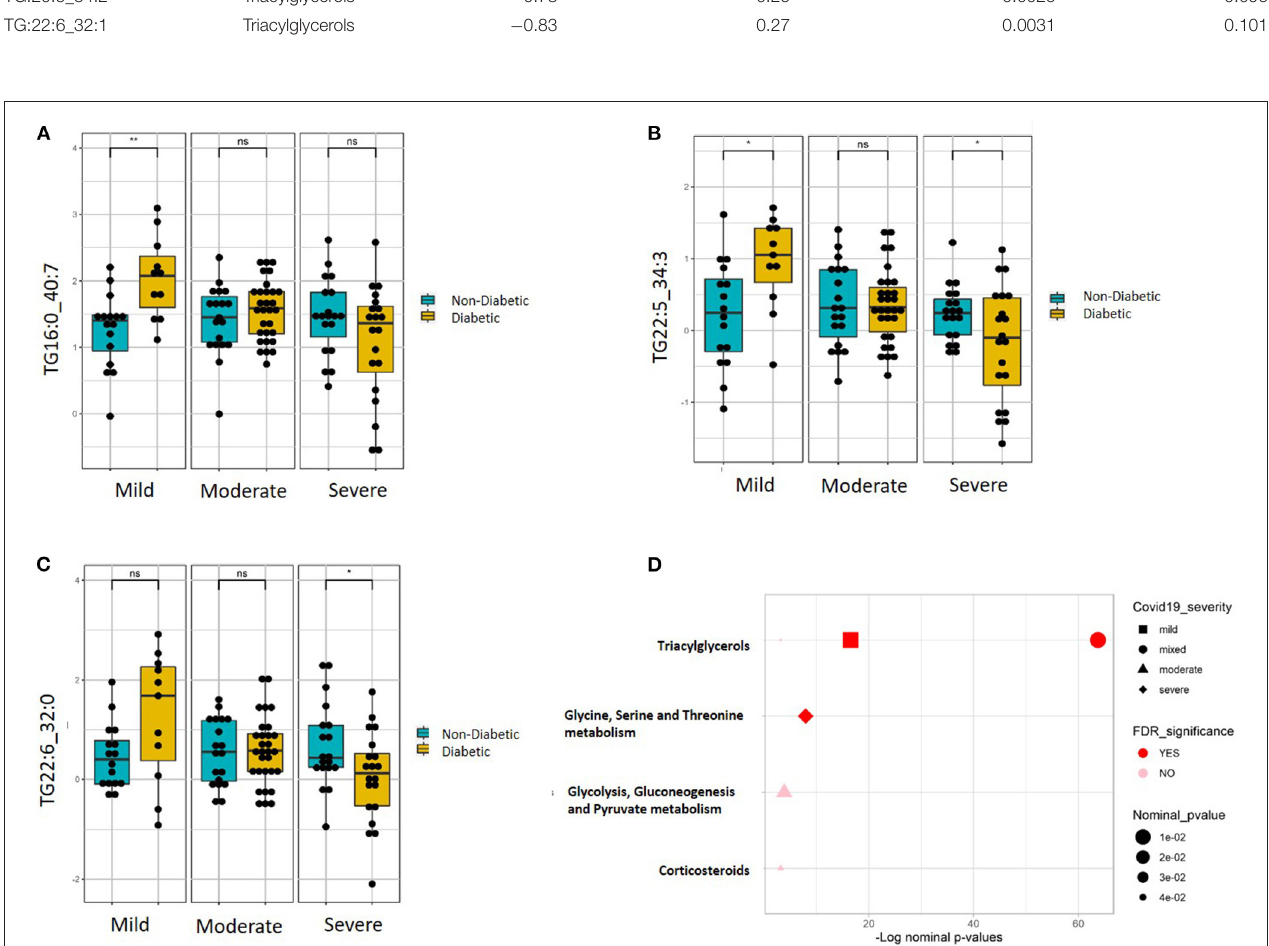
FIGURE 3 | Metabolites associated with COVID-19 severity levels in diabetic and non-diabetic patients. Examples of top metabolites containing (A) C16:0, (B) C22:5, and (C) C22:6, which show significantly different slopes between diabetic and non-diabetic patients from regressing the given metabolite on the ordinal COVID-19 severity levels (FDR < = 0.05). (D) Enriched metabolite classes in terms of COVID-19 disease severity. * p ≤ 0.05, ** p ≤ 0.01, ns, not significant.